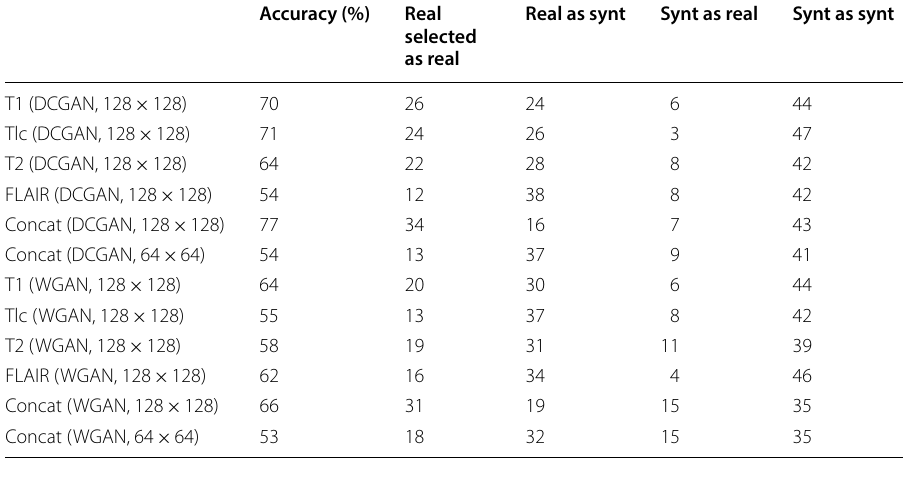
Table 6 Results of ‘Visual Turing Test’ on different DCGAN- and WGAN [104]—generated brain tumor MR images presented by Han et al. [140]